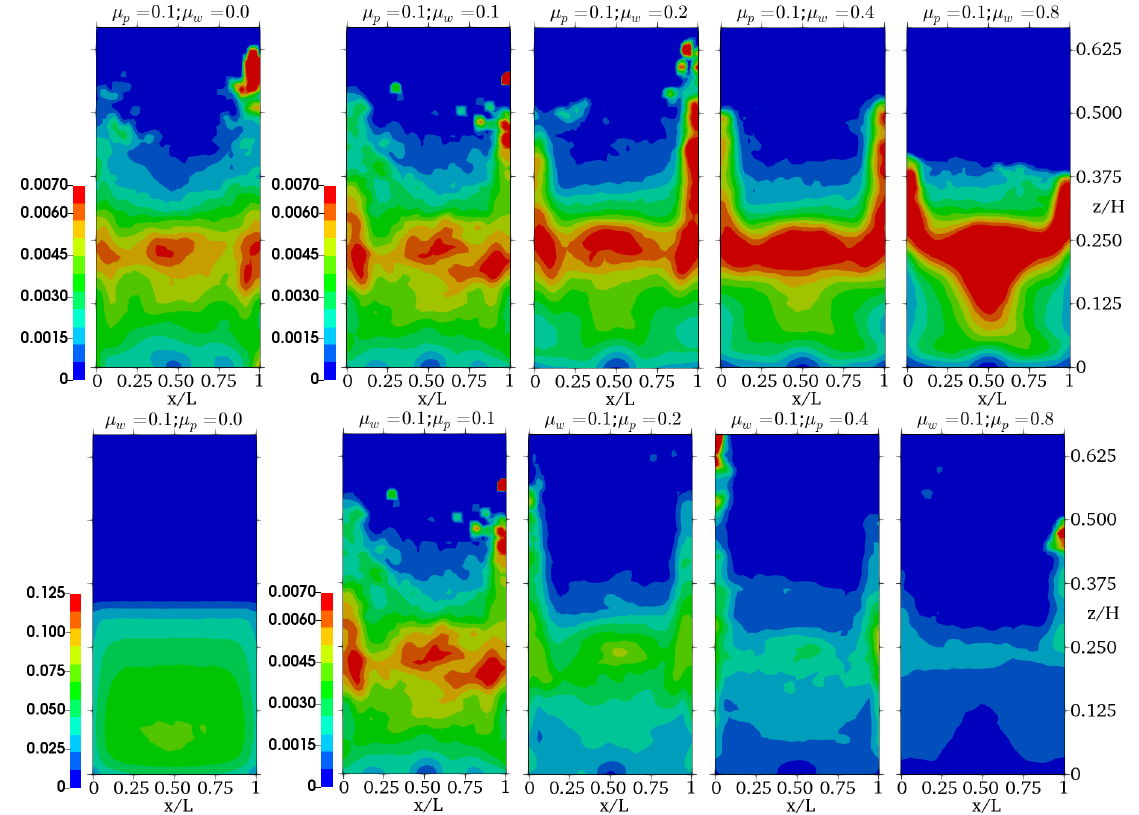
Figure 16. Time-averaged dimensionless particle agitation energy, q 2 p / U 2 particle-wall µ w and the particle-particle µ p friction coefficients. Upper panel: constant µ p and different µ w . Bottom panel: constant µ w and different µ p . Re p = 70 and bed weight 75